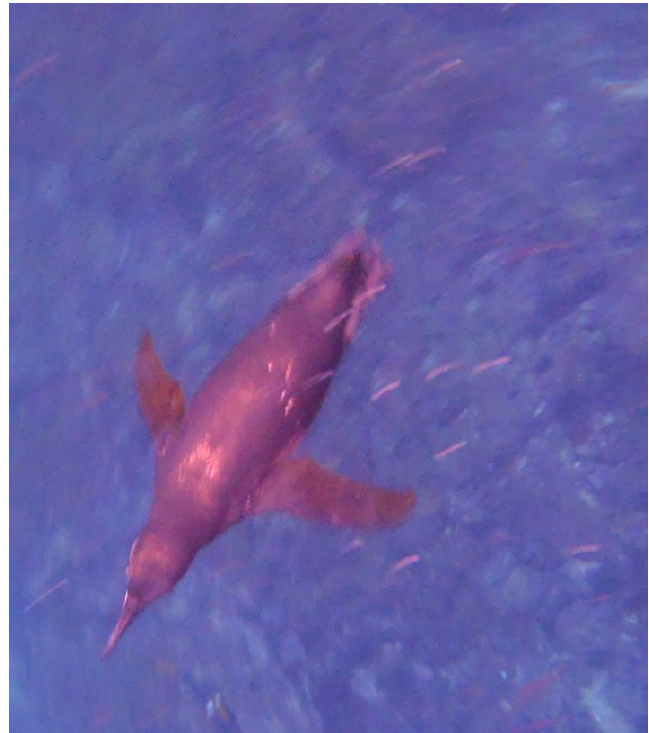
Figure 2. A Galapagos penguin Spheniscus mendiculus forages in tropical waters above a rocky benthic substrate. Off Punta Vicente Roca, Galapagos Islands, Ecuador. Credit: PWH. In some circumstances, prey bioluminescence and the reflection from the seabed can increase the amount of available, useful light. For instance, chinstrap penguins Pygoscelis antarcticus have been found to sometimes dive as deep as 110 m at night when hunting lanternfish [31]; lanternfish possess bioluminescence, which may help the penguins locate them in low light conditions. While this might seem a rather unhelpful adaptation for the lanternfish, it may attract higher level predators to the penguin [32]. Different benthic substrates absorb, reflect, and re ‐ emit light (fluoresce), and some highly reflective sub ‐ strates show increasing light intensity with depth [33], particularly in more shallow wa ‐ ters. This aids benthic feeders, such as the yellow ‐ eyed penguin [28]. Nevertheless, all penguins need to have useful vision both in air, where they breed and raise their young, and underwater, where they forage. In addition, at least some of the larger, deeper ‐ diving species need to be able to see under the very low light conditions experienced at depth in the long night of the Antarctic winter. Therefore, to understand the penguin visual system one must examine how it functions both on land and at sea, as well as its ability to provide useful vision under dim light conditions. 1.4. Aim of the Review Here we aimed to review what is known of the penguin eye and its visual perfor ‐ mance. We have organized the results according to anatomical site or physiological vari ‐ able. Particular attention was given to features that answer two critical questions that the